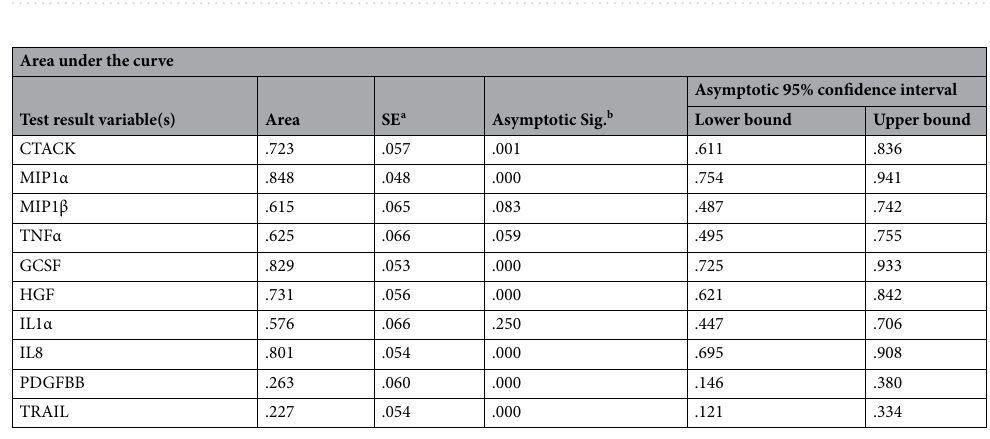
Table 2. Area under the ROC curve of clustering analysis of cytokines diagnosing Meniere’s disease. The test result variable(s): CTACK, TransfMIP1α, TransfMIP1β, TransfTNFα, TransfGCSF, TransHGF, TransIL1α, TransIL8, TransfPDGFBB, TransfTRAIL has at least one tie between the positive actual state group and the negative actual state group. Statistics may be biased. a Under the nonparametric assumption. b Null hypothesis: true area =